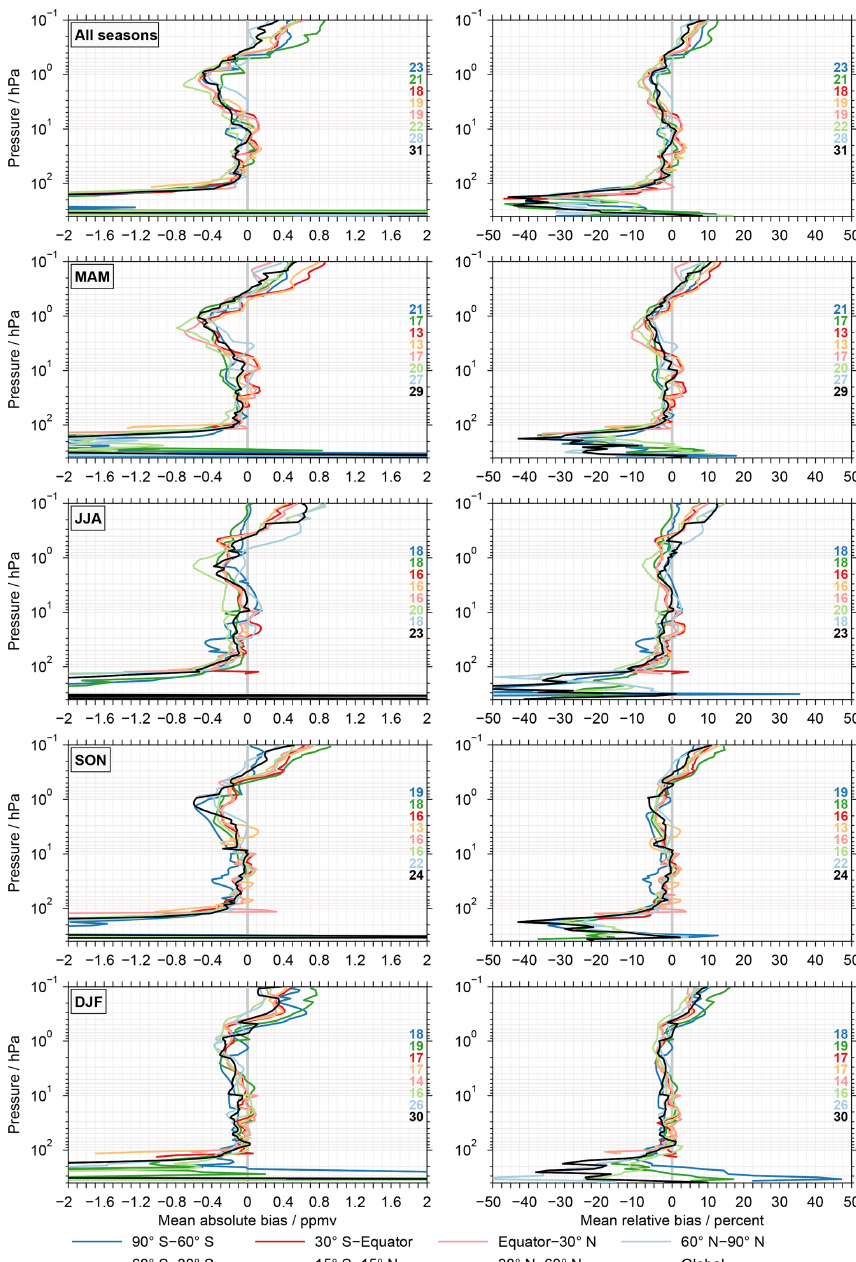
Figure 9. Bias summary for the ACE-FTS v3.5 data set. The left column considers the absolute biases and the right column the relative biases. As in Figs. 6 and 7 the different rows focus on the results for different seasons or their combination. In the individual panels on the right the number of comparisons contributing to the summary are indicated. As described in Sect. 3.5 the number of comparisons to the different MIPAS data sets are counted individually, even though these results are